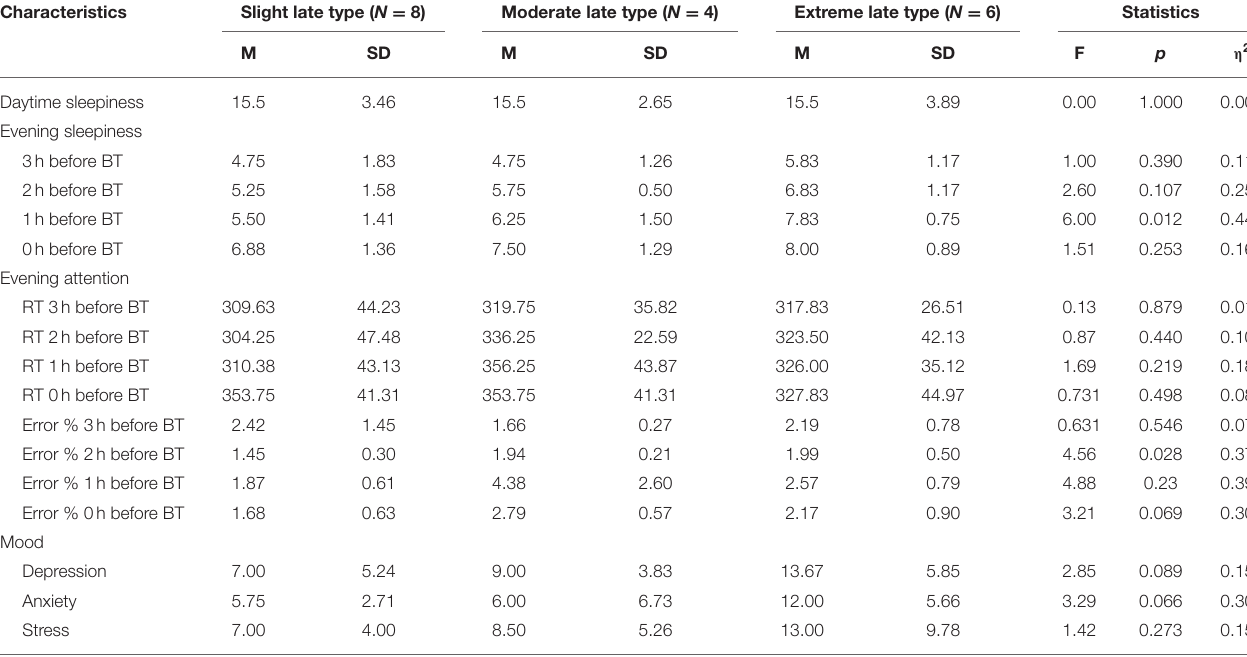
TABLE 3 | Descriptive and inferential statistics for daytime sleepiness, evening sleepiness, and sustained evening attention, as well as mood in chronotype subgroups. Characteristics